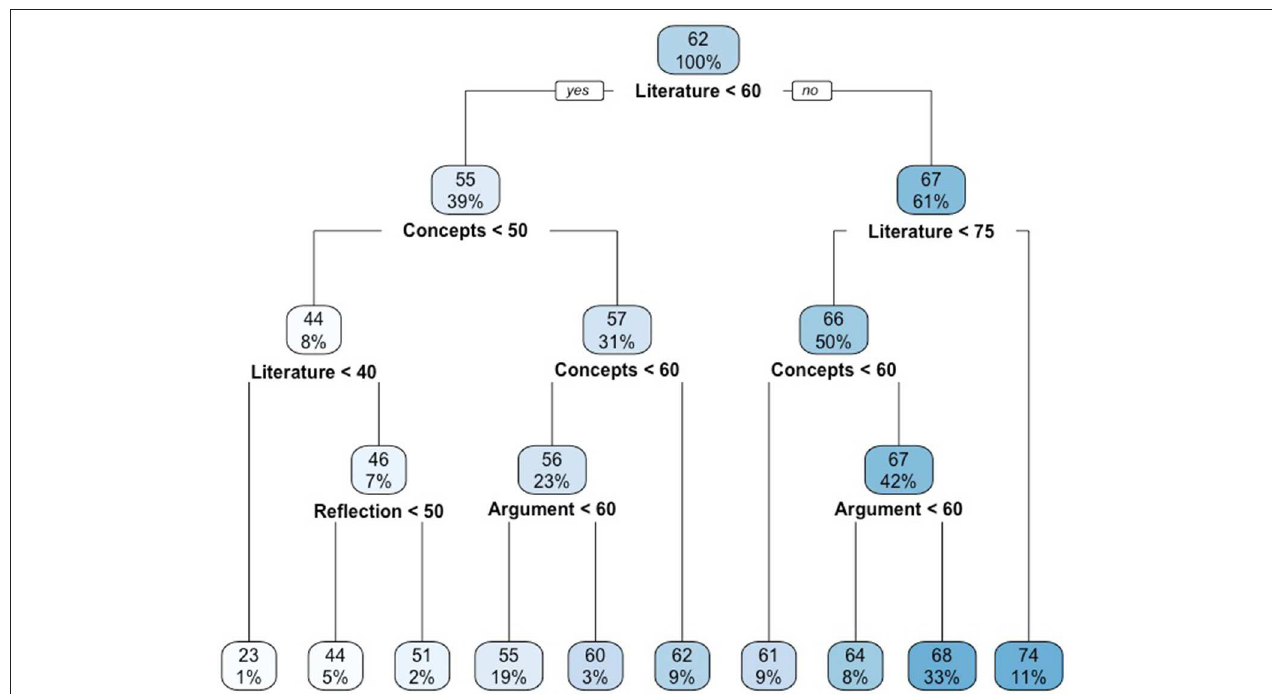
FIGURE 4 | Simplified decision tree for year 2 exams, pruned after 9 splits for illustrative purposes. The top number in each node is the percentage mark prediction at that point in the tree, and the bottom number is the percentage of the sample contained within that node. Literature: Relevance and range of the literature; Concepts: Descriptions and explanations of concepts and relation between them; Argument: Development of the argument; Reflection: Critical reflection on the work of